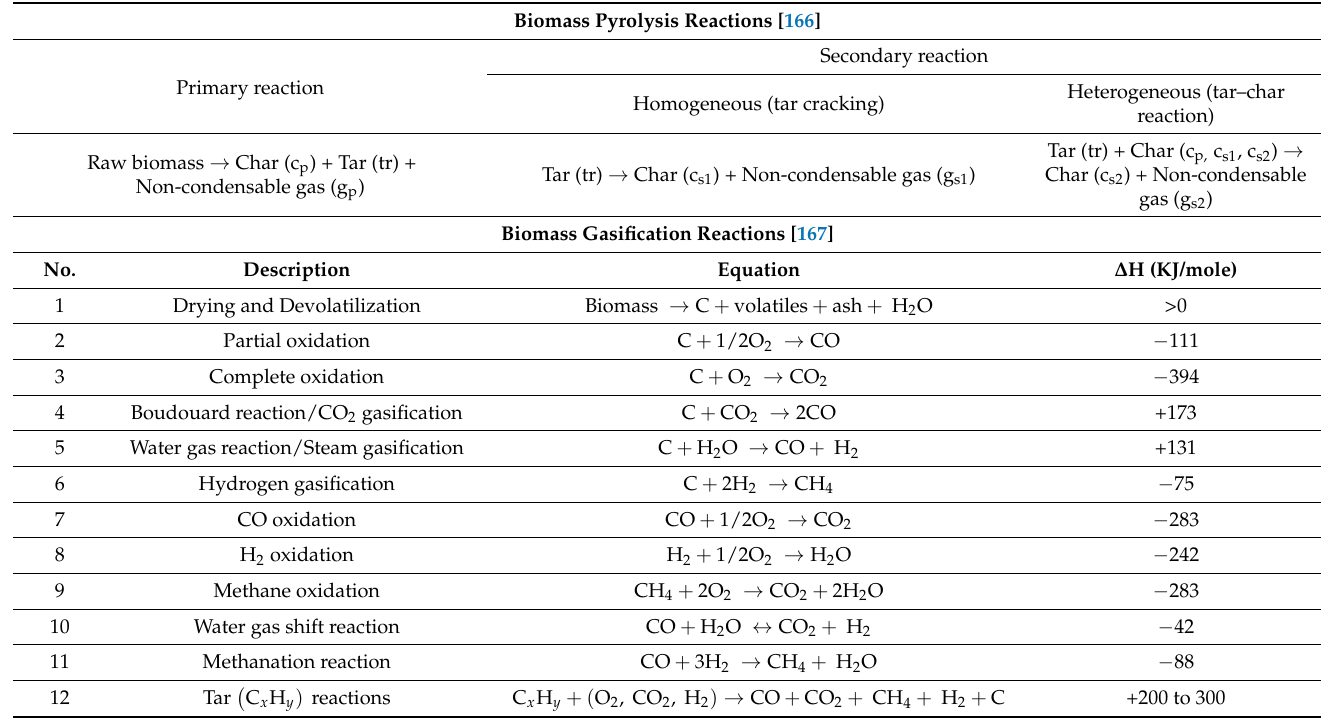
Table A1. Biomass pyrolysis and gasification